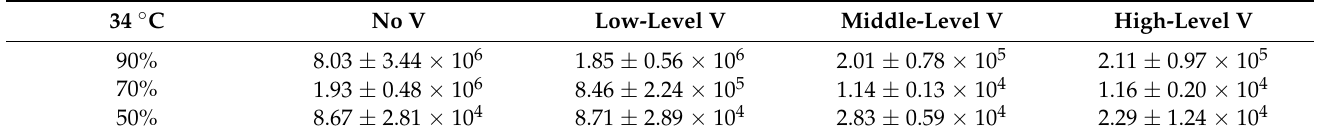
Figure 5. The bacterial growth (fold change compared to the base value measured after washing in tap water, before placing into the cabinets) in the meat under different working conditions at 34 °C. ( A ) No ventilation and different ventilation levels at 90%, 34 °C; ( B ) no ventilation and different ventilation levels at 70%, 34 °C; ( C ) no ventilation and different ventilation levels at 50%, 34 °C. * p < 0.05 vs. no ventilation 90%; *** p < 0.001 vs. no ventilation 90%; # p < 0.05 vs. no ventilation 70%; ## p < 0.01 vs. no ventilation 70%; ### p < 0.001 vs. no ventilation 70%; $ p < 0.05 vs. no ventilation 50%. & p < 0.05 vs. low-level V; && p < 0.01 vs. low-level V. Table 2. The bacterial growth (fold change) in meat under different working conditions at 34 °C.